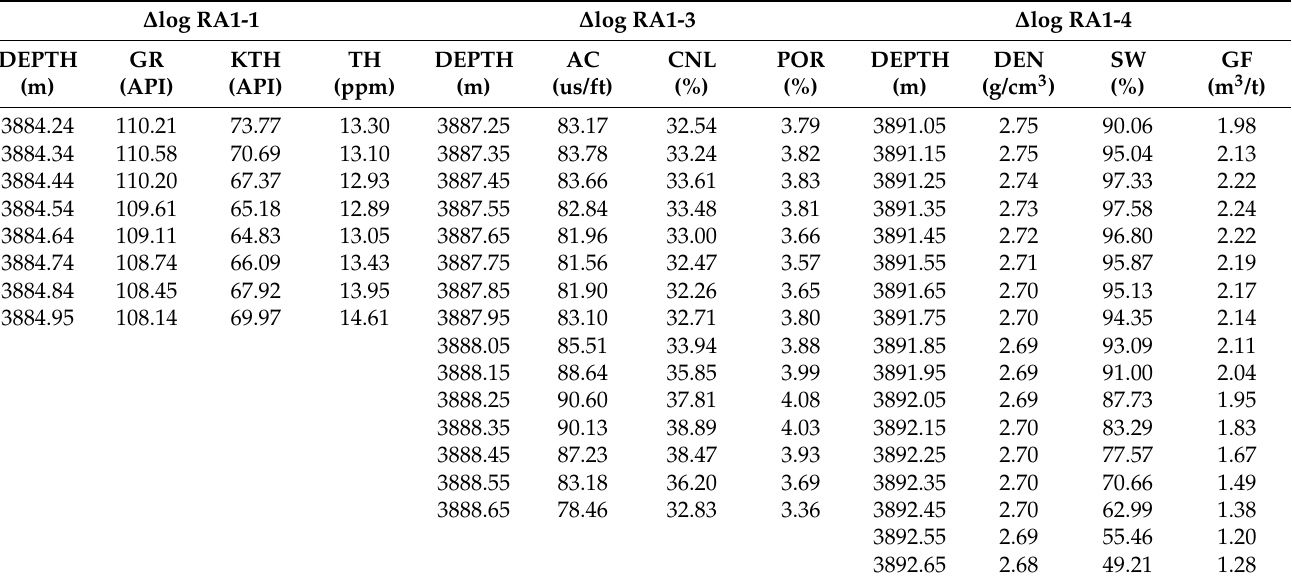
Table 9. Actual logging data corresponding to ∆ logR1-1, ∆ logR1-3, and ∆ logR1-4 in A1